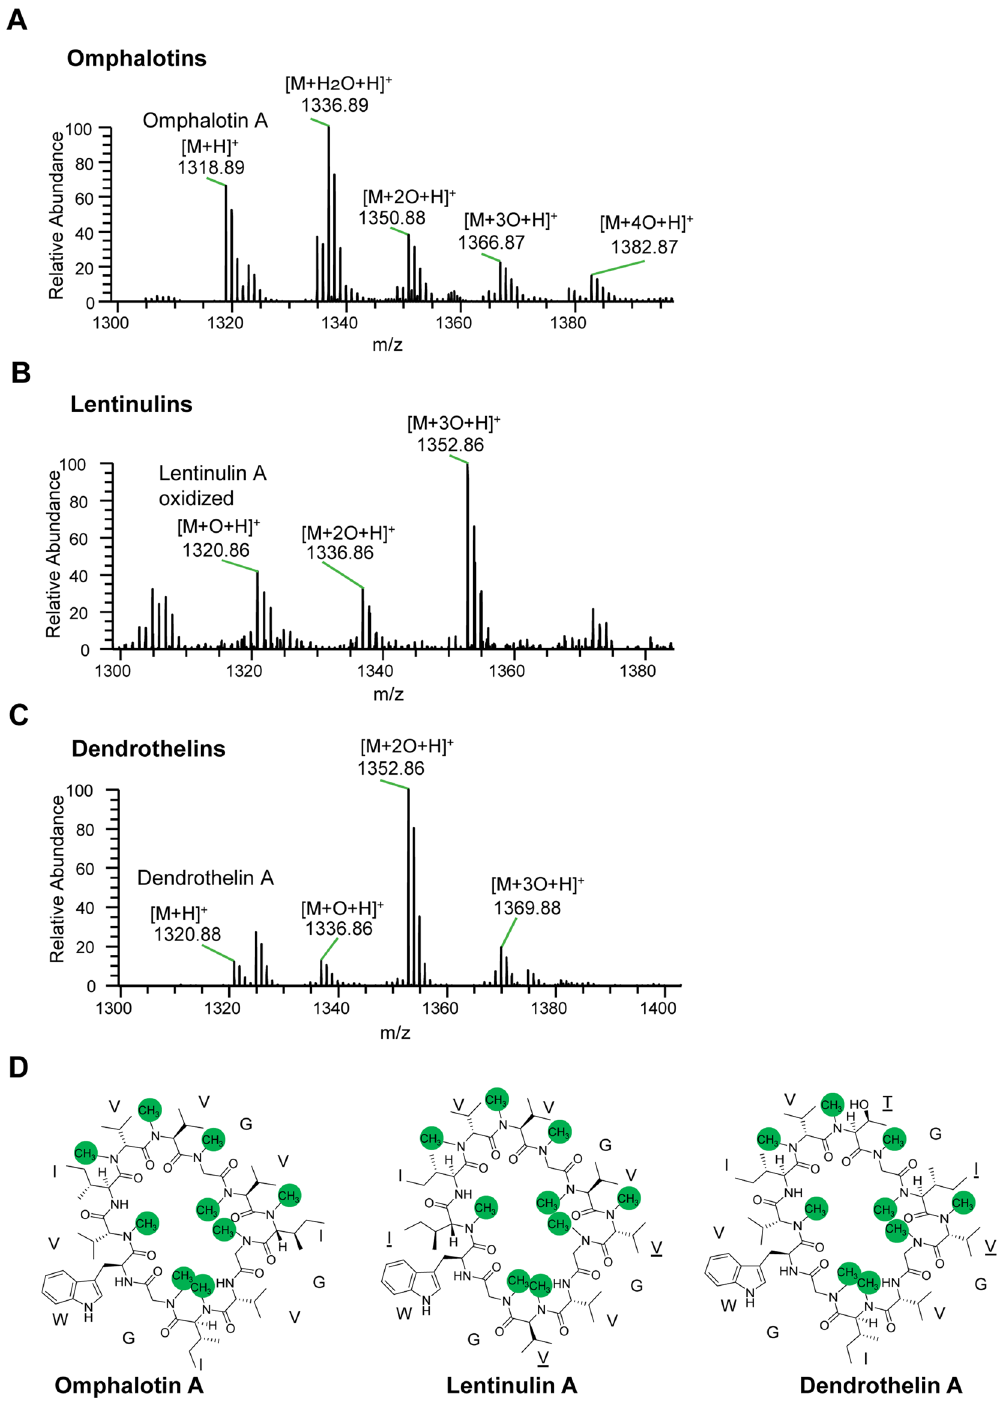
Figure 4. LC–MS analysis of backbone N-methylated peptides extracted from mushrooms O. olearius , L. edodes and D. bispora . ( A – C ) Ion chromatograms depicting some of the peptides species produced by 28 days liquid cultures of the respective fungi. In case of O. olearius ( A ) and D. bispora ( B ), both backbone- N-methylated macrocyclic peptides (M + H + ) and additionally oxidized macrocyclic peptides (M + nO + H) + thereof were observed in the culture supernatant. In case of the L. edodes liquid culture ( C ) , oxidized cyclic peptides were detected in the fungal mycelium. (M + 2HO + H) + represents the linear form of the macrocyclic peptide. ( D ) Chemical structures of omphalotin A, lentinulin A and dendrothelin A. Residues different from omphalotin A are underlined. Backbone N-methylation is indicated by green